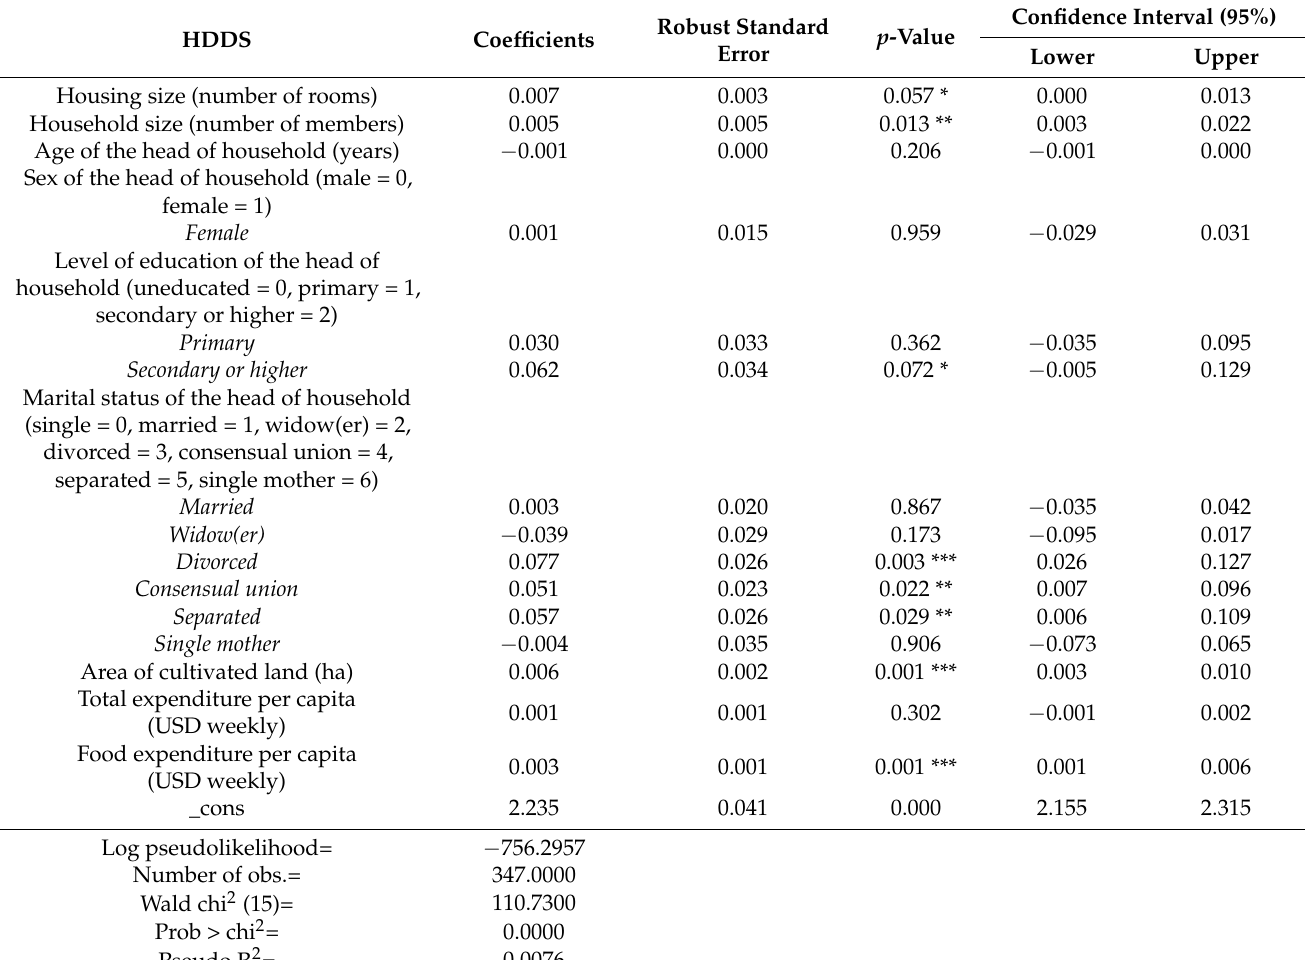
Table 2. Results of the robust Poisson regression analysis showing the factors that determine the HDDS in rural households.